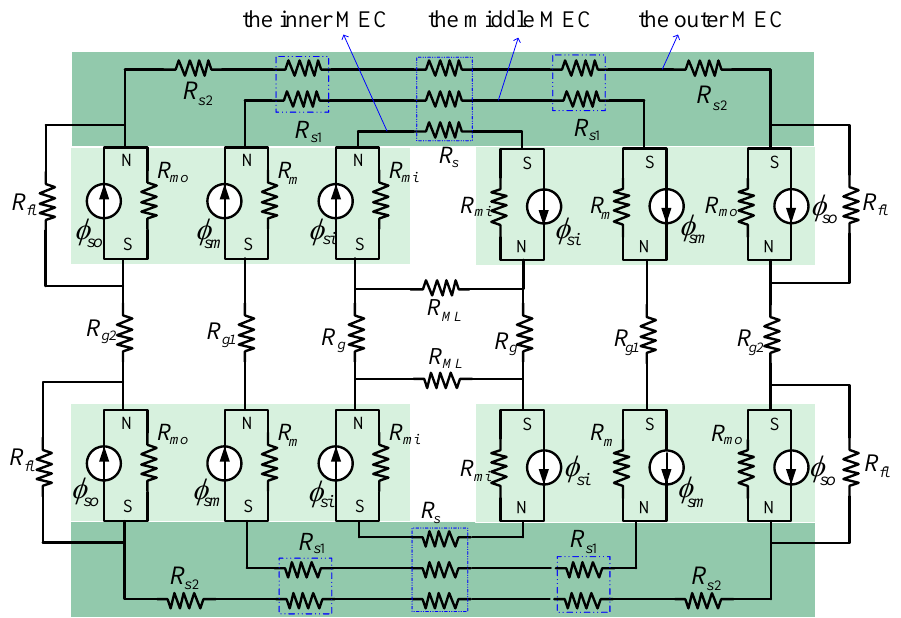
Figure 6. Proposed MEC of the LM